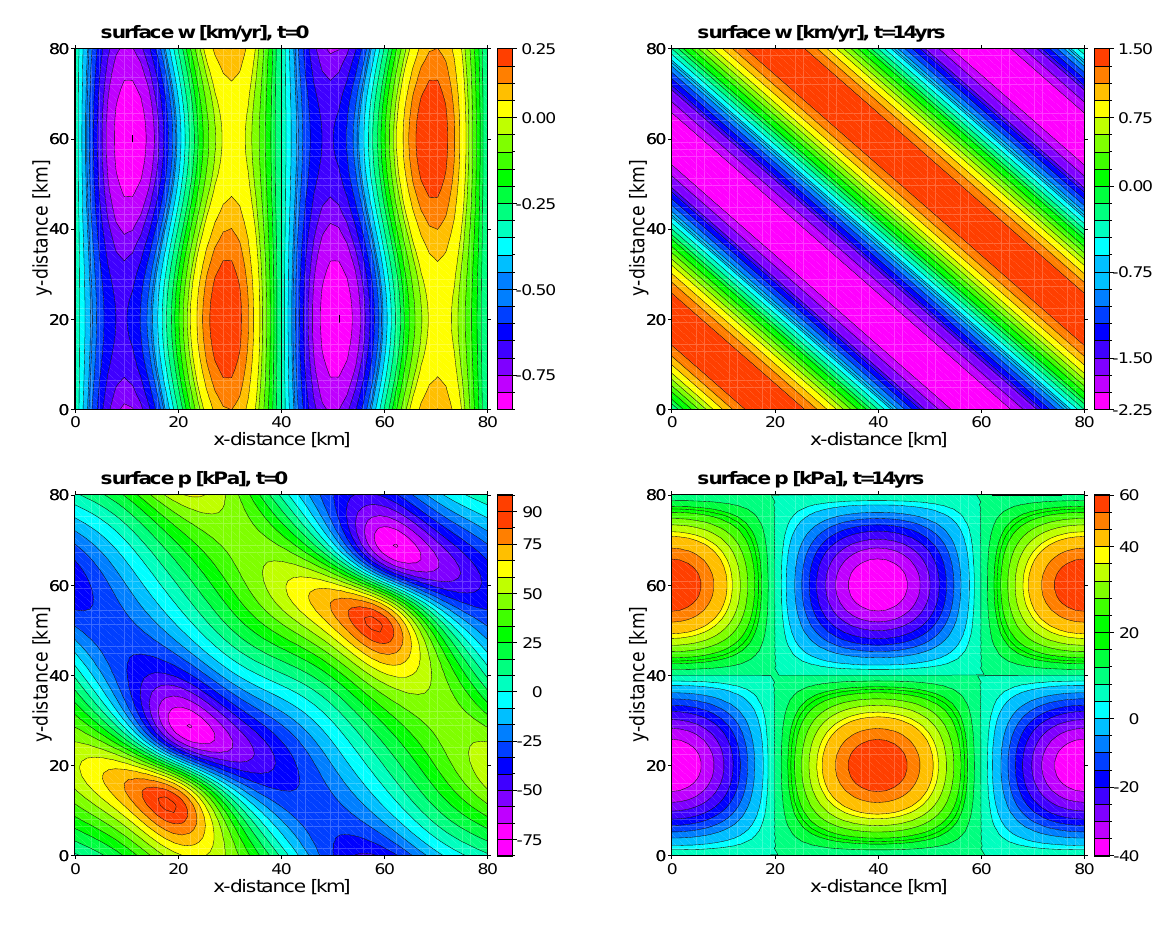
Fig. 8. 3-D time dependent experiment; the graphs show the ice surface vertical velocity w (in km/yr) and the ice surface pressure p (in kPa) at the beginning (left) and at the time when the steady-state solution is reached